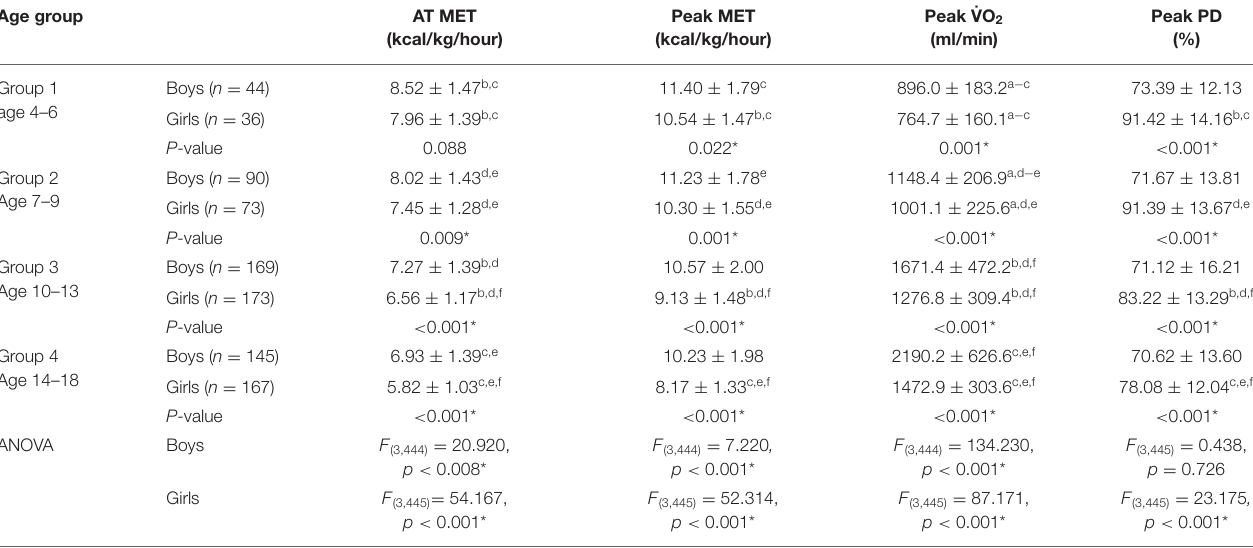
TABLE 2 | Comparison of cardiopulmonary fitness during exercise testing between two sexes in relation to age group. Age group AT MET (kcal/kg/hour)